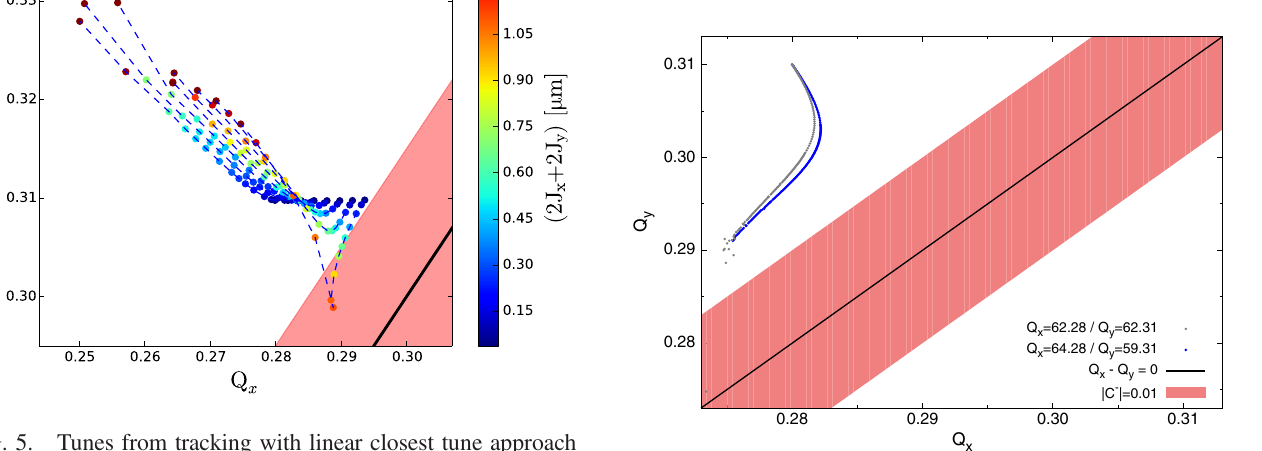
FIG. 6. Comparison of tracking simulations with incremental vertical kicks, for optics configurations with Q x ¼ 64 . 28 , Q y ¼ 59 . 31 and Q 62 . 28 , Q 62 . 31 . In both cases j C − j ¼ 0 . 01 x ¼ y ¼ and Landau octupoles are applied with a strength of − 3 m −